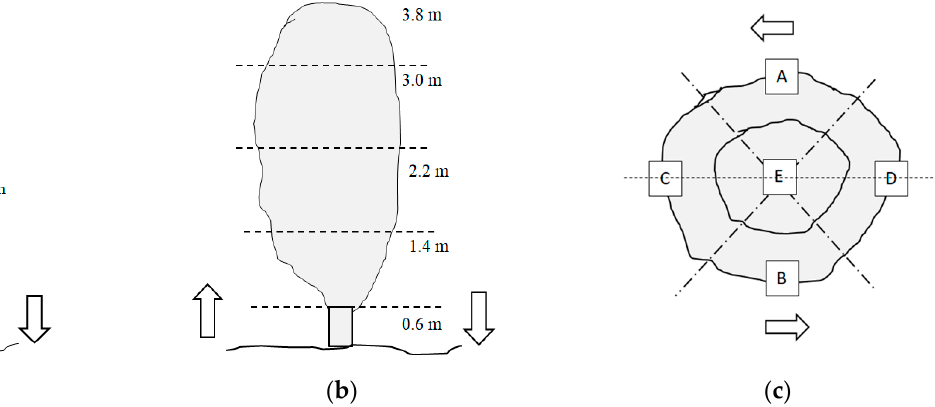
Figure 3. Schematic diagram of fruit tree canopy segmentation. ( a ) Height division of the peach canopy, ( b ) height division of the pear canopy, ( c ) horizontal division of the canopy.